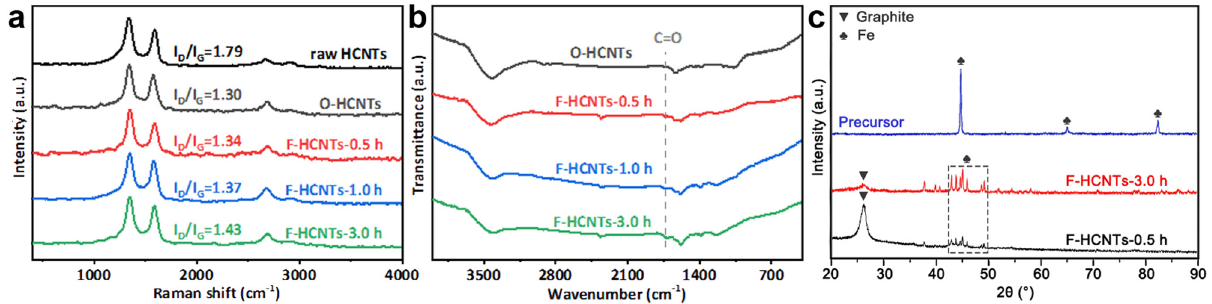
Figure 2: Structural analysis of HCNTs: ( a ) the Raman spectra, ( b ) the FT - IR spectra, and ( c ) the XRD patterns of O - HCNTs, F - HCNTs treated for 0.5, 1, and 3